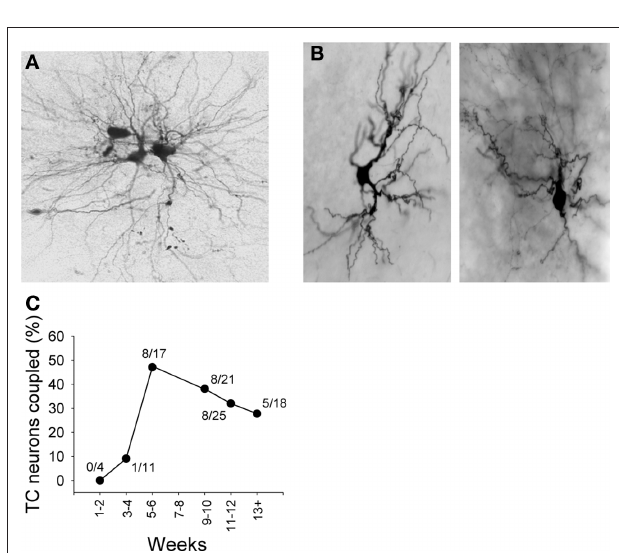
FiGurE 5 | Examples of dye-coupling between LGN TC neurons and its lack amongst local circuit interneurons. (A) Example of dye-coupling amongst TC neurons. In this experiment only one neuron was injected with dye. (B) Examples showing lack of dye-coupling in association with LGN interneurons. (C) Plot showing the percentage of TC neurons associated with dye-coupling in LGN slices from animals at different ages